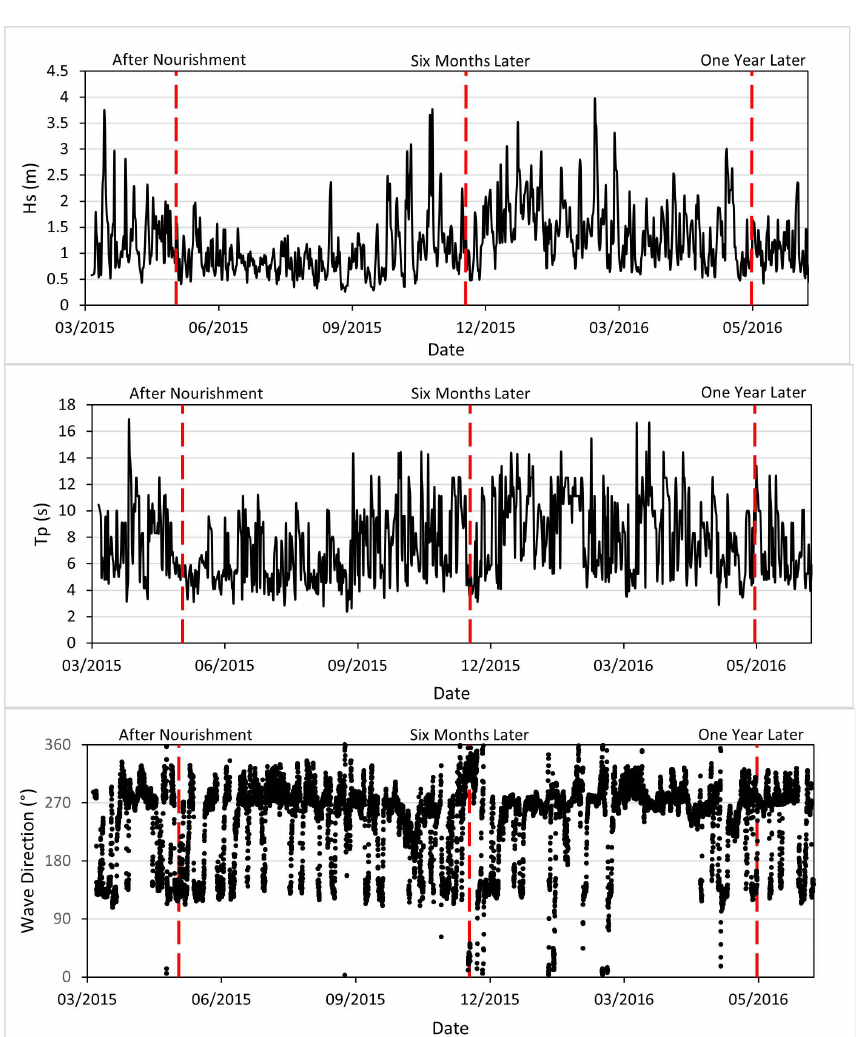
Figure 3. Wave data during the monitoring time between March 2015 and June 2016: Hs (in meters, ( top )), Tp (in seconds, ( centre )), and wave direction (being 0 ◦ and 360 ◦ in the north, 90 ◦ in the east, 180 ◦ in the south, and 270 ◦ in the west, ( bottom )). The survey dates used in the analysis are marked vertically. Source: own elaboration with data from the Spanish port administration www.puertos.es (15 August